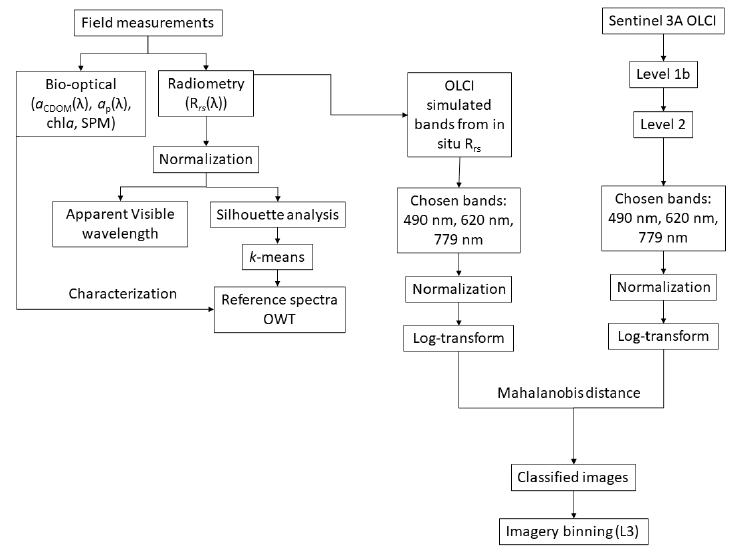
Figure 2. Methodological framework showing all the steps used to develop this study.